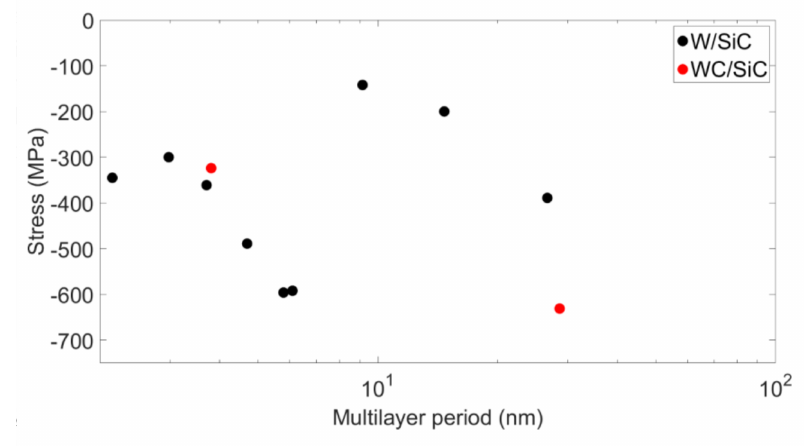
Figure 2. Stress in as-deposited W/SiC (black) and WC/SiC (red) multilayers as a function of multilayer period.